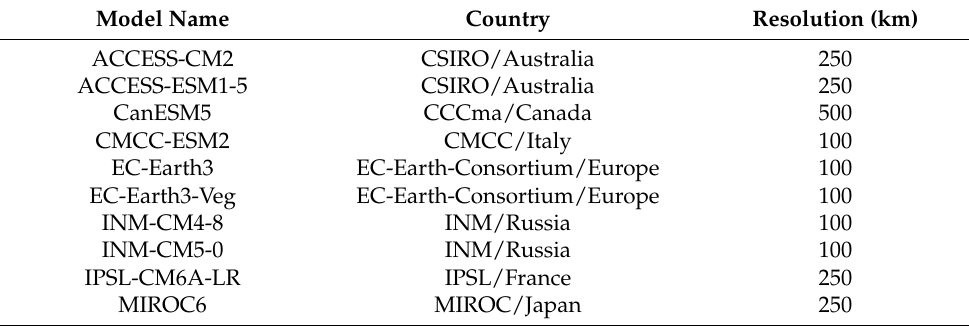
Table 2. CMIP6 model